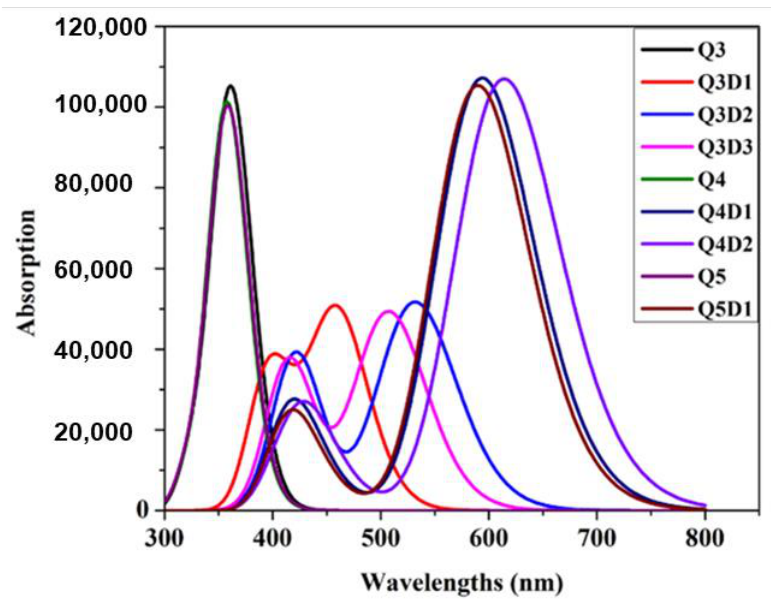
Figure 4 . Simulated absorption spectra of studied compounds. Figure 4. Simulated absorption spectra of studied